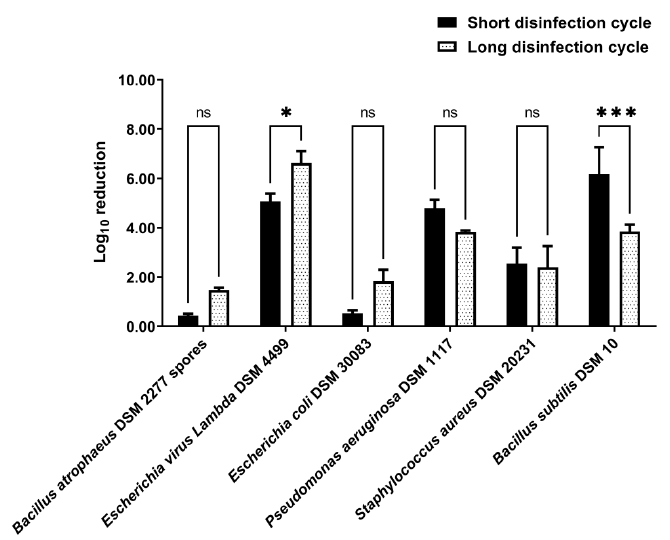
Figure 5. Log 10 reduction achieved in disinfection of fabric by nebulization in the upscaled 0.58 m 3 closet. VIRCOV BAC 360 disinfectant was used at a 1/3 ( v / v ) dilution. The indicators tested were B. atrophaeus DSM 2277 spores, bacteriophage Lambda DSM 4499, E. coli DSM 30083, Pseudomonas aeruginosa DSM 1117, S. aureus DSM 20231, and Bacillus subtilis DSM 10. For the disinfection time, a short disinfection cycle and a long disinfection cycle were tested. The short disinfection cycle consisted of 2 min of nebulization, 2 min of rest without nebulization, and 2 min of aerosol extraction from the closet interior. For its part, the long disinfection cycle consisted of 4 min of nebulization, 4 min of rest without nebulization, and 2 min of aerosol extraction from the closet interior. The error bars in the graph represent the standard deviation of the mean of three replicates ( n = 3). Statistical difference between groups was evaluated by two-way ANOVA with post hoc comparisons made by the Tukey test. ns: not significant with p -value > 0.05; *: significant with p -value < 0.05; ***: sig- nificant with p -value < 0.001.